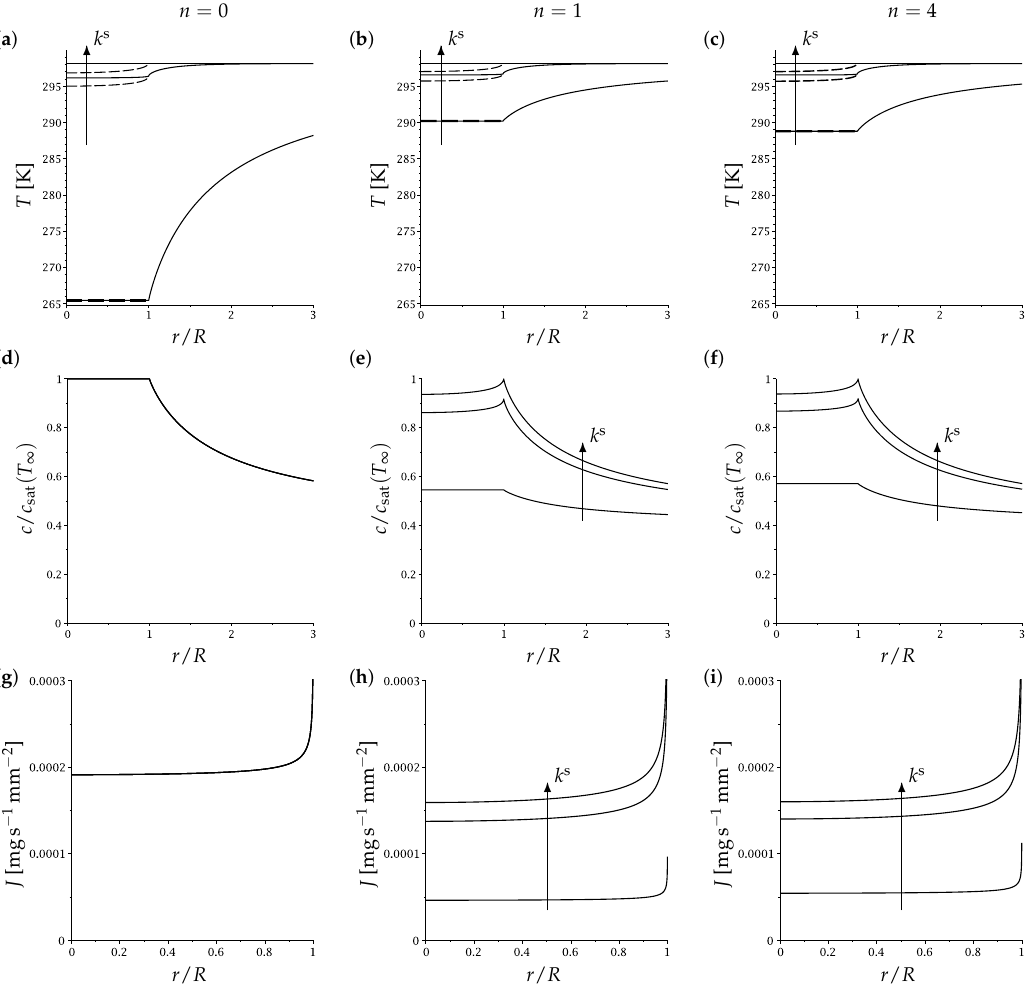
Figure 2. Numerically calculated solutions for ( a – c ) the temperature, ( d – f ) the vapour concentration, and ( g – i ) the evaporative flux for a droplet of water with contact angle θ = 1.361 radians and contact radius R = 1.86 mm evaporating into air with T ∞ = 298.15 K on a perfectly conducting substrate ( k s = ∞ ), a PTFE substrate ( k s = 0.25 Wm − 1 K − 1 ), and a perfectly insulating substrate ( k s = 0). In ( a – c ) the dashed curves show the temperature along the free surface of the droplet for r < R and the solid curves show the temperature along the upper surface of the substrate, while ( d – f ) show the con- centration along the free surface of the droplet for r < R and along the upper surface of the substrate for r > R . Column [( a , d , g )] was obtained using n = 0 in Equation (6), column [( b , e , h )] was obtained using n = 1, and column [( c , f , i )] was obtained using n = 4. The arrows indicate the direction of increasing k s